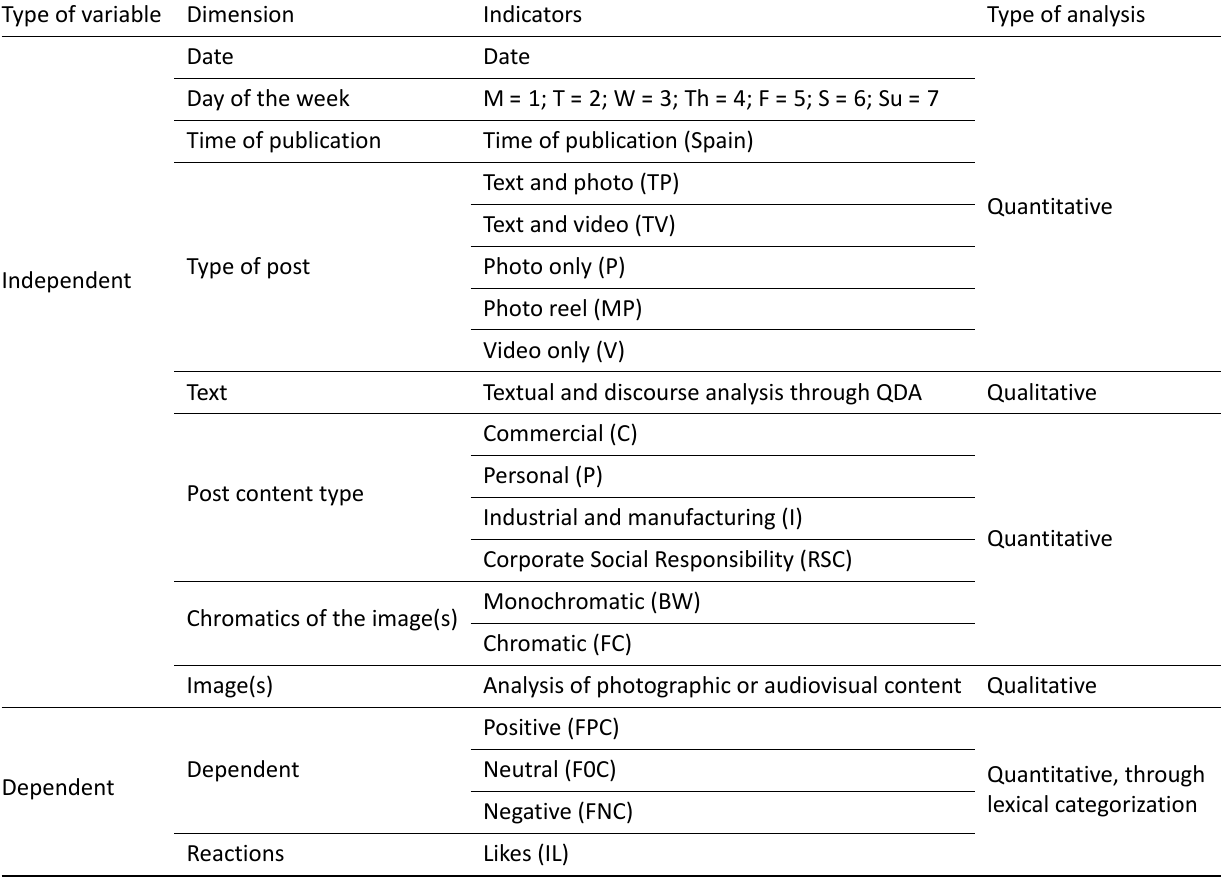
Table 1. Definition of the study’s variables, dimensions, and indicators. Type of variable